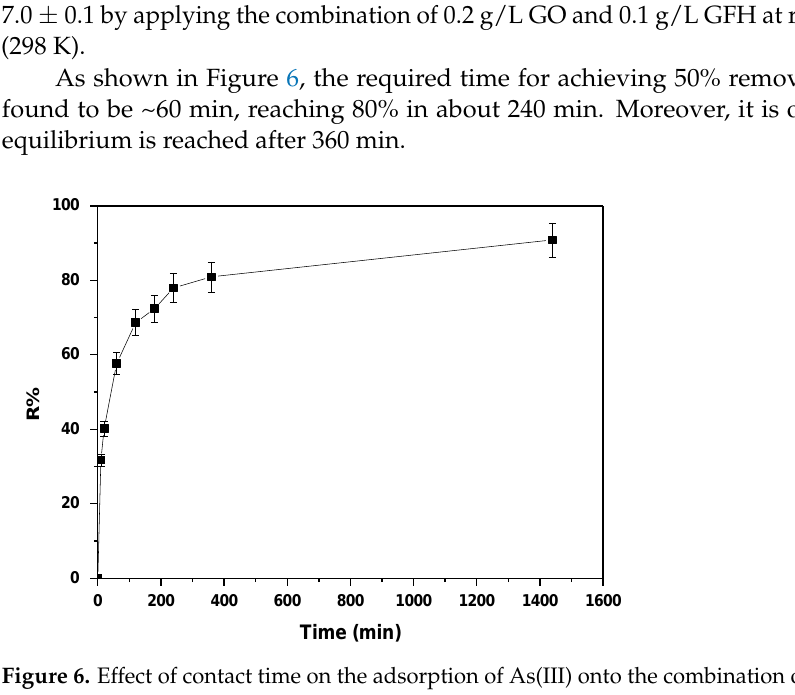
Figure 6. Effect of contact time on the adsorption of As(III) onto the combination of GO (0.2 g/L) and GFH (0.1 g/L); initial As(III) concentration 100 µ g/L, pH 7.0 ± 0.1, T = 298 K, in deionized water.